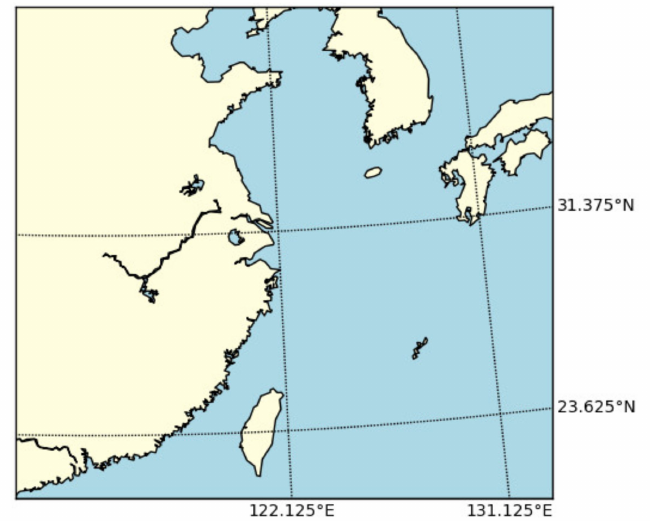
Figure 5. The selected area of the East China